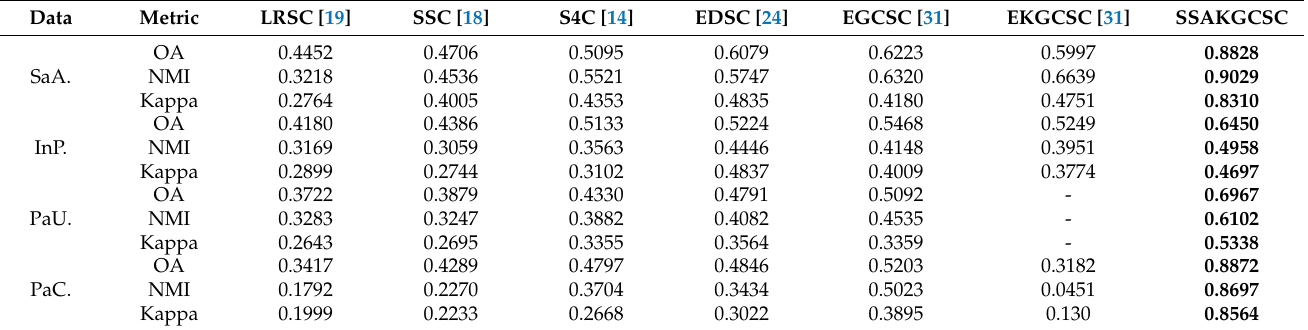
Table 6. Clustering performance of the compared methods on SalinasA, Indian Pines, Pavia Univer- sity, and Pavia Center data sets with Gaussian noise (the mean is 0 and the variance is 0.2) and salt and pepper noise (the probability is 0.1).